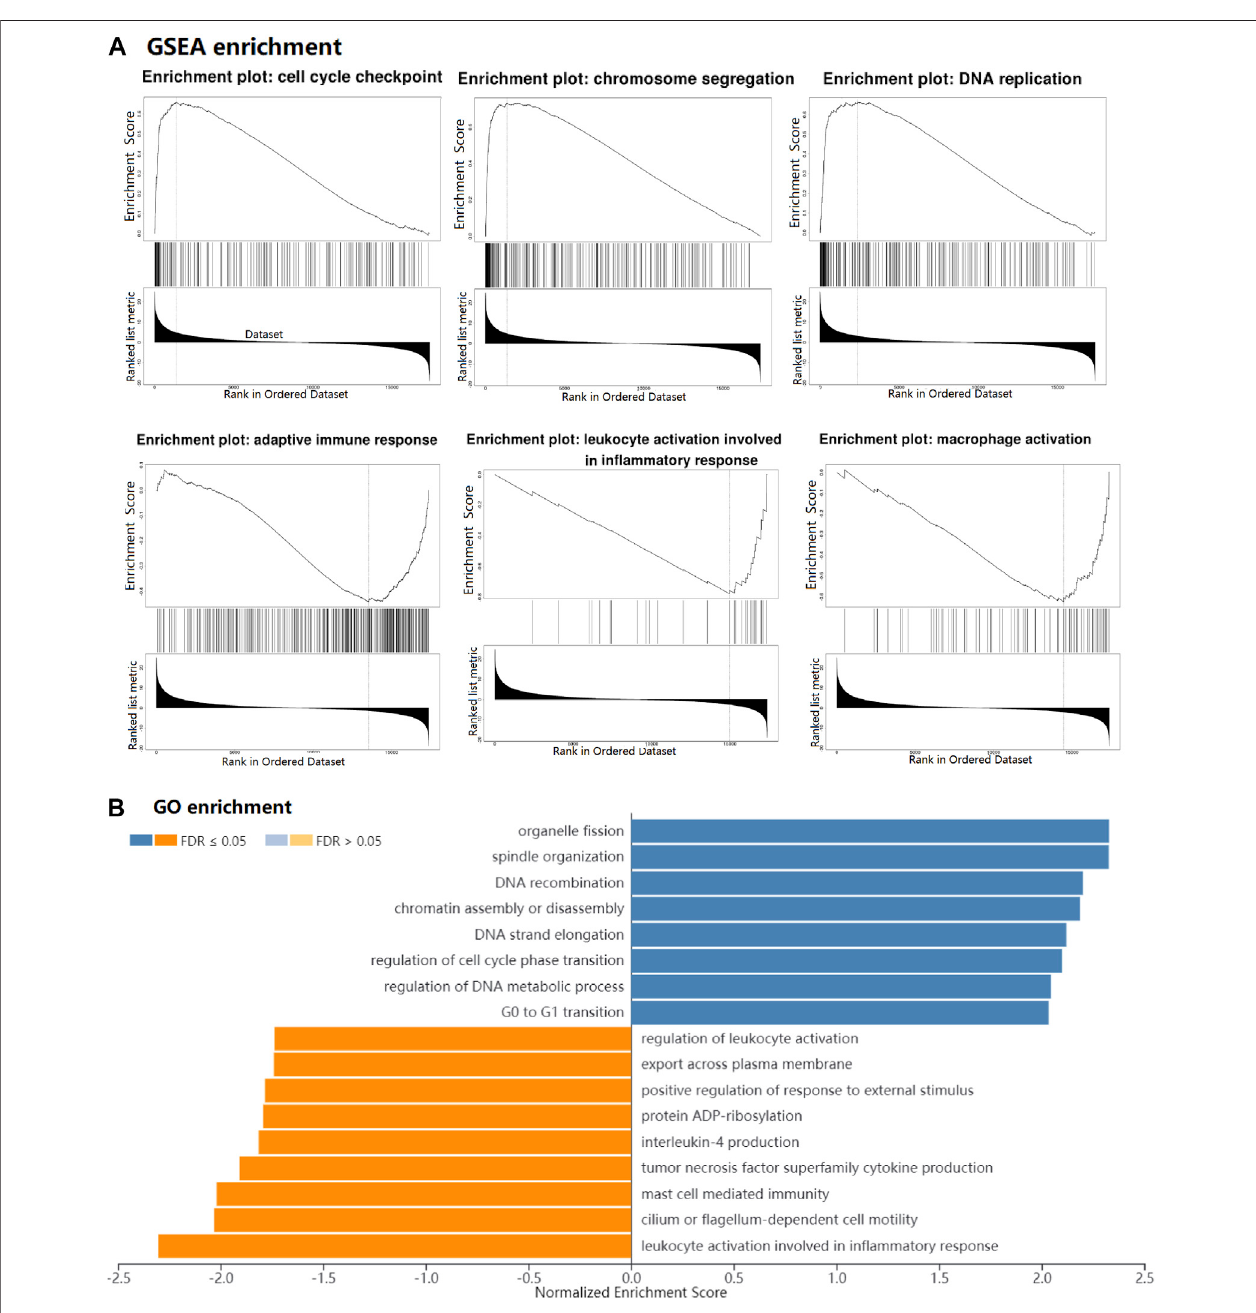
FIGURE 9 | GSEA and functional enrichment of the IGF2BP1 gene in LUAD. (A) GSEA of IGF2BP1 in LUAD by LinkedOmics. (B) GO enrichment of IGF2BP1 in LUAD. Blue bar means positively associated biological process, and yellow bar means negatively associated biological process.